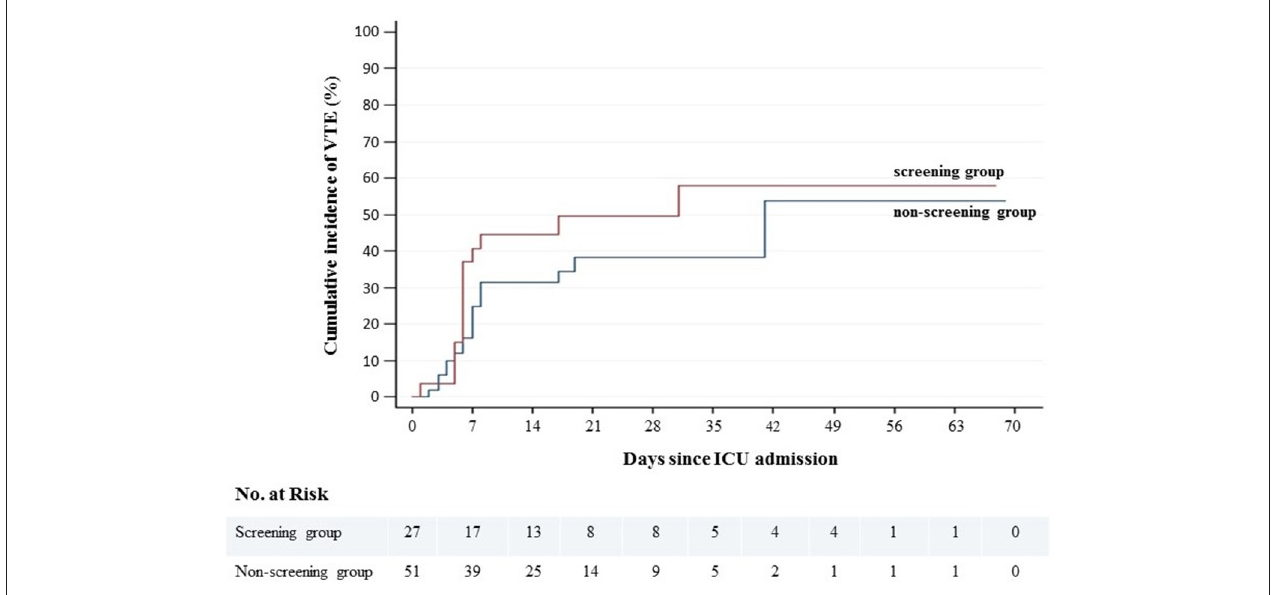
FIGURE 1 | Cumulative incidence of venous thromboembolism according to screening or not for LE-DVT.